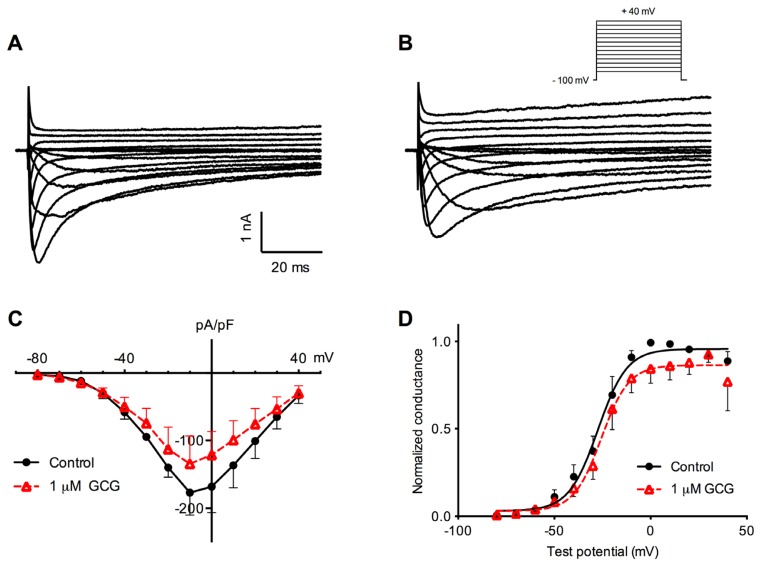
Effects of GCG on the activation of tetrodotoxin-resistant Na+ currents. (A,B) Original recordings of tetrodotoxin-resistant Na+ currents under control condition (A) and after treatment with 1 μM GCG (B); (C) Averaged current-voltage (I–V) curves of tetrodotoxin-resistant Na+ currents before (filled circle) and after (unfilled triangle) 1 μM GCG application; (D) Conductance-voltage (G-V) relationships derived from I–V data (n = 6).